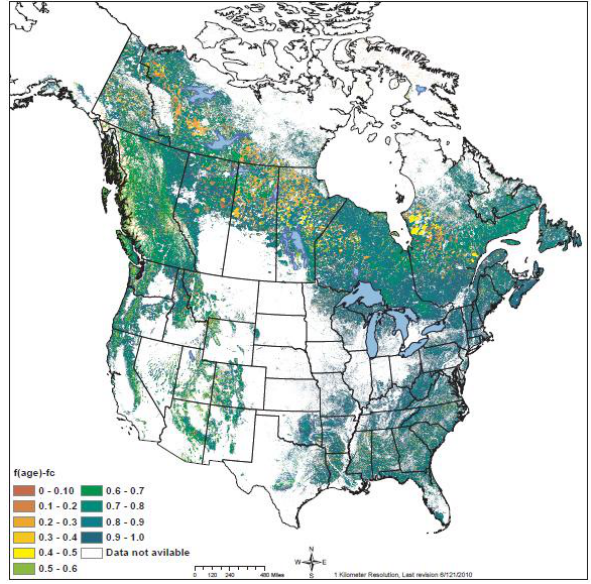
Fig. 8. Forest age factor derived from the forest age map (Fig. 1a) Figure 8. Forest age factor derived from the forest age map (Figure 1) useful for constraining useful for constraining atmospheric inverse modeling of the bio- atmospheric inverse modeling of the biosphere carbon flux. sphere carbon